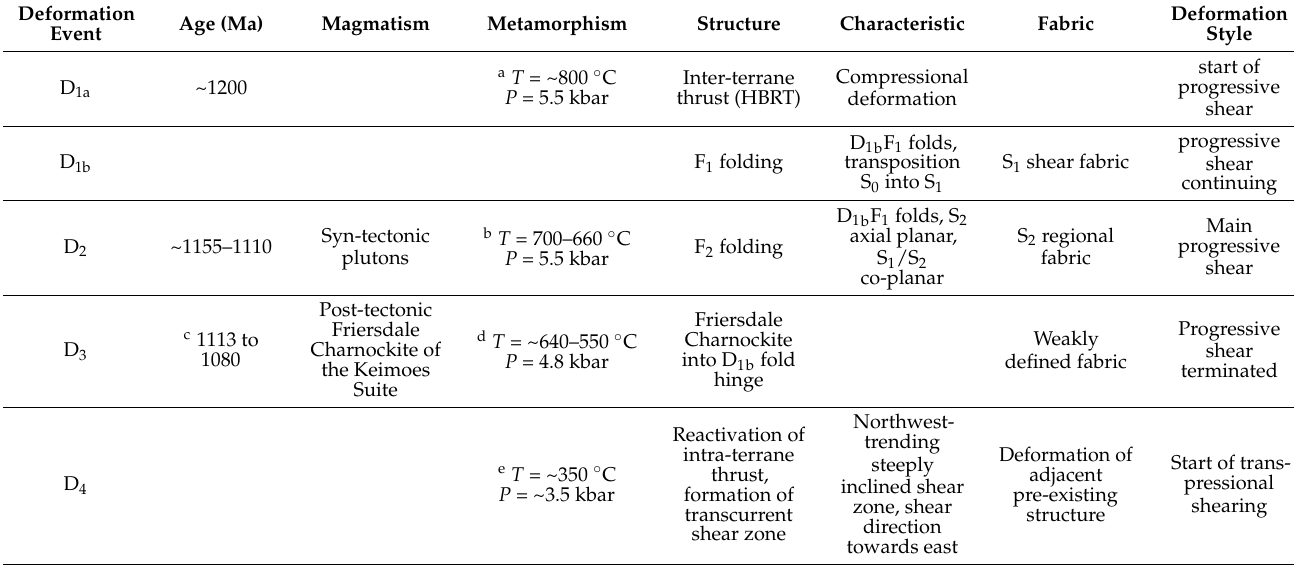
Table 2. Tectonic framework of the study area in the Kakamas Domain, eastern Namaqua Sector. Deformation